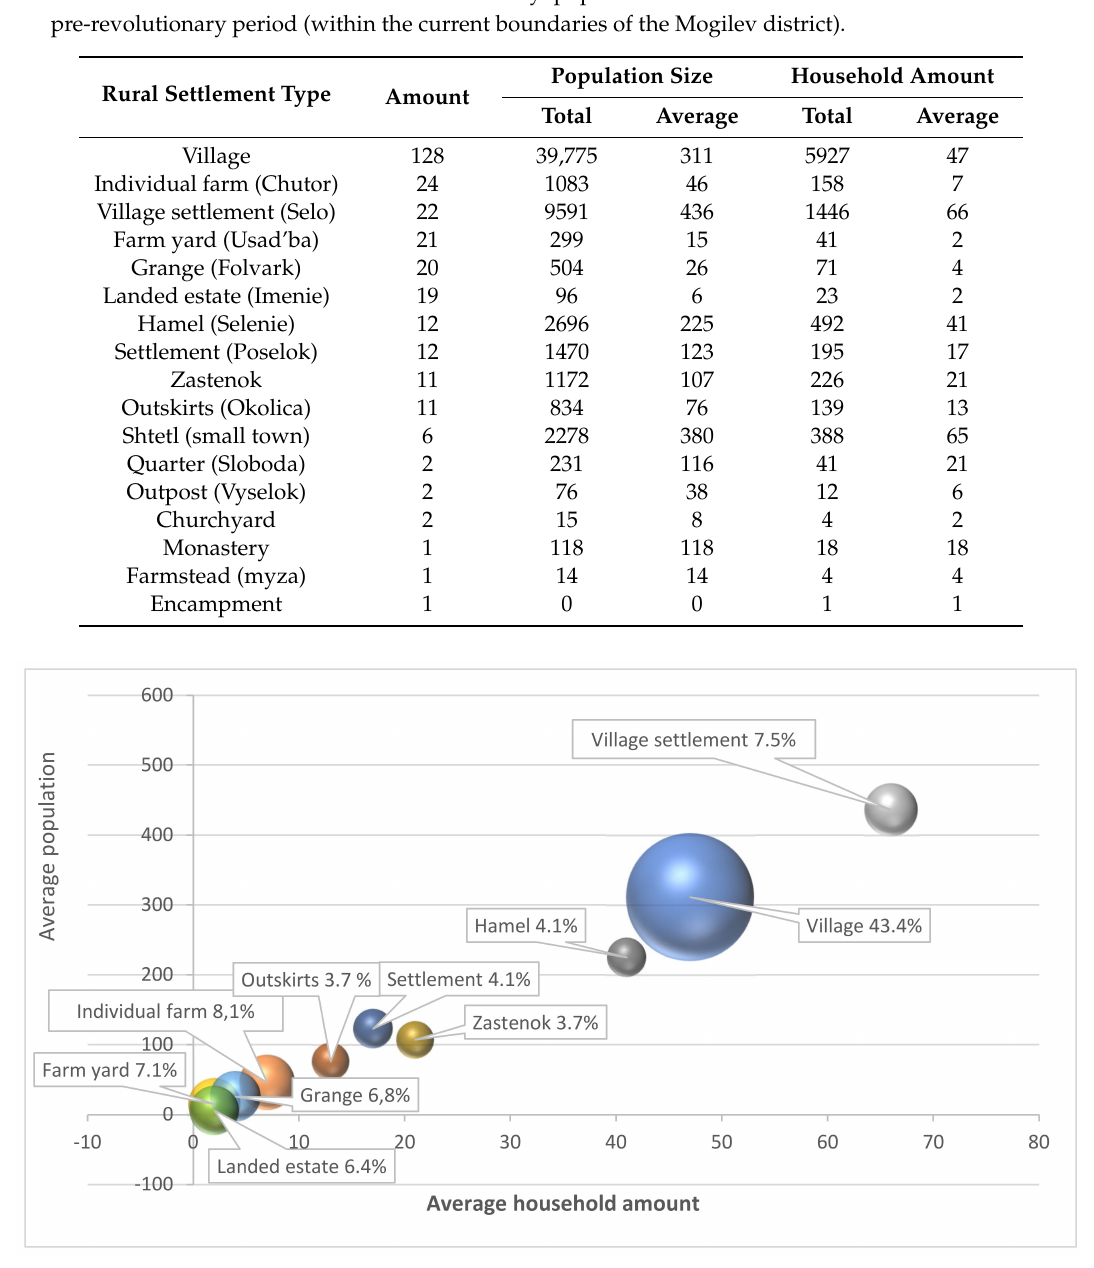
Figure 3. Distribution of rural settlements by size / share in the pre-revolutionary period (within the current boundaries of the Mogilev